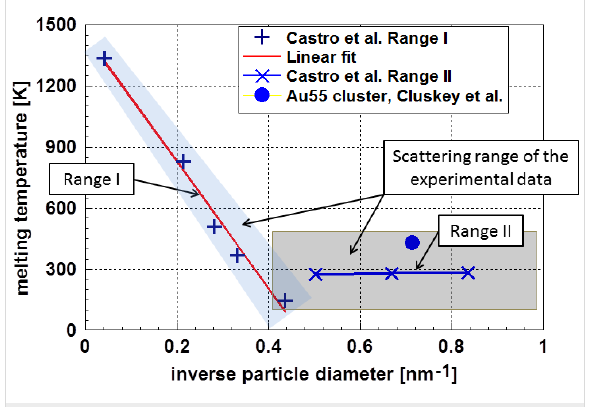
Figure 1: Melting temperature of gold nanoparticles according to Castro et al. [11] and Cluskey et al. [13]. One realizes two ranges in the data of Castro et al.: Within the experimental error bar (shaded area) results of Castro et al., the result of Cluskey et al., obtained on Au 55 clusters, is also